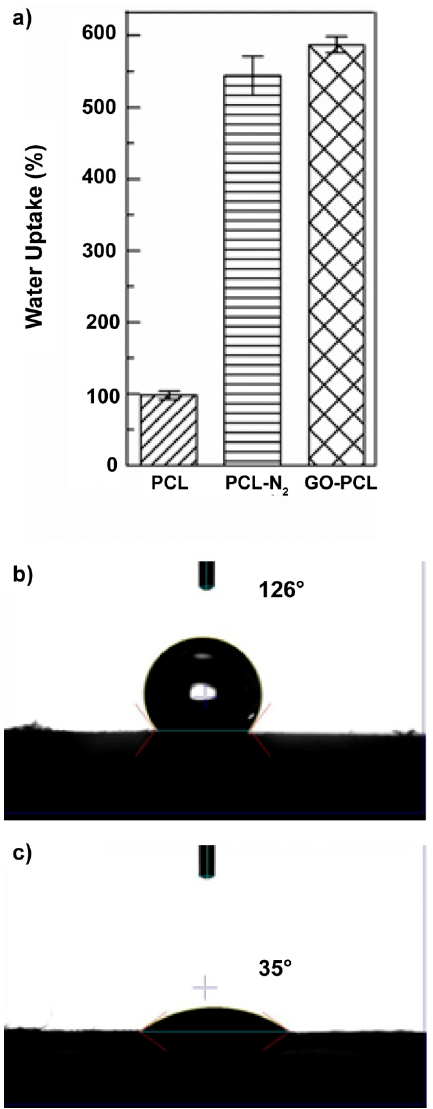
Figure 2. Water uptake ( a ) and water contact angle measurements for the virgin PCL ( b ) and GO–PCL patches ( c ).